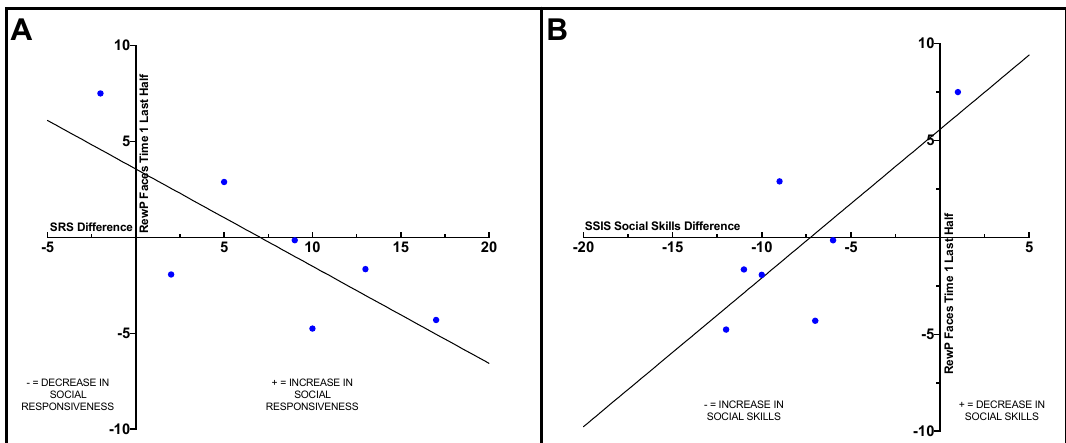
Figure 2. ( a ) Correlation between SRS-2 difference score before and after intervention in the ASD group and reward positivity (RewP) mean amplitude in the last half of the social condition at Time 1 ( r = − 0.77, p = 0.04). ( b ) Correlation between SSIS social skills difference score before and after intervention in the ASD group and RewP mean amplitude in the last half of the social condition at Time 1 ( r = 0.78, p = 0.04).